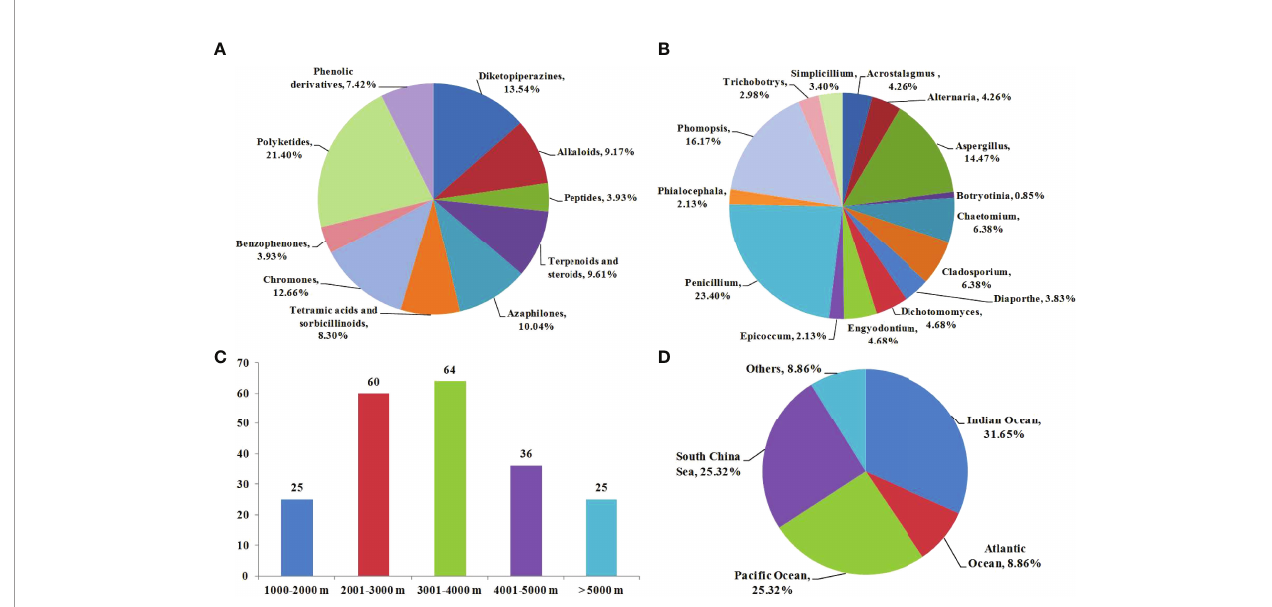
FIGURE 13 | (A) Chemical structures categories of the described compounds isolated from deep-sea fungi; (B) Producing strains categories of the isolated compounds; (C) Distribution categories of the producing strains; (D) Geographic origins of the isolated